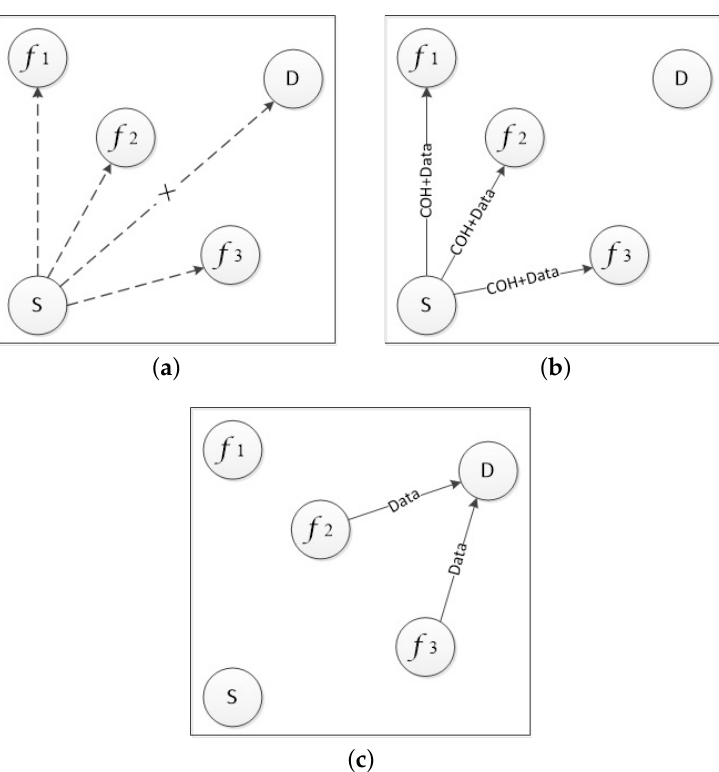
Figure 2. The procedure of information exchanges in optimal cooperative ad hoc-medium access control (OCA-MAC). ( a ) Original status. ( b ) Potential cooperative nodes selection. ( c ) Cooperative